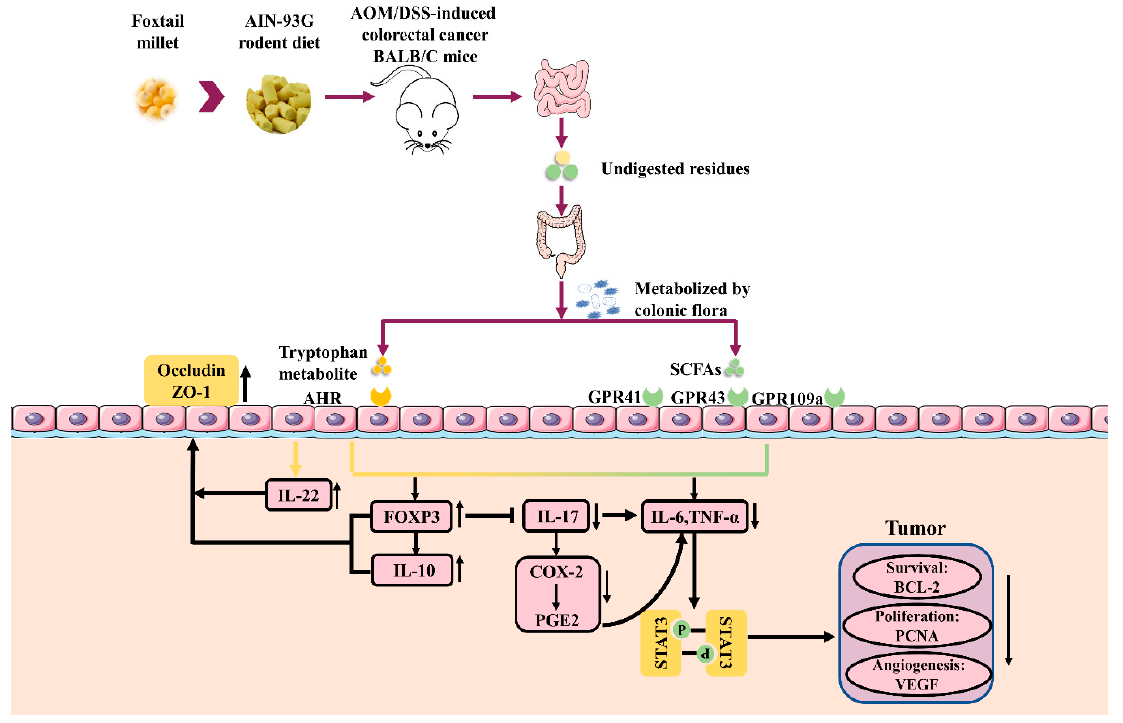
Figure 9. Mechanism of the regulatory effects of foxtail millet on the progression of colitis-associated colorectal cancer (CRC).